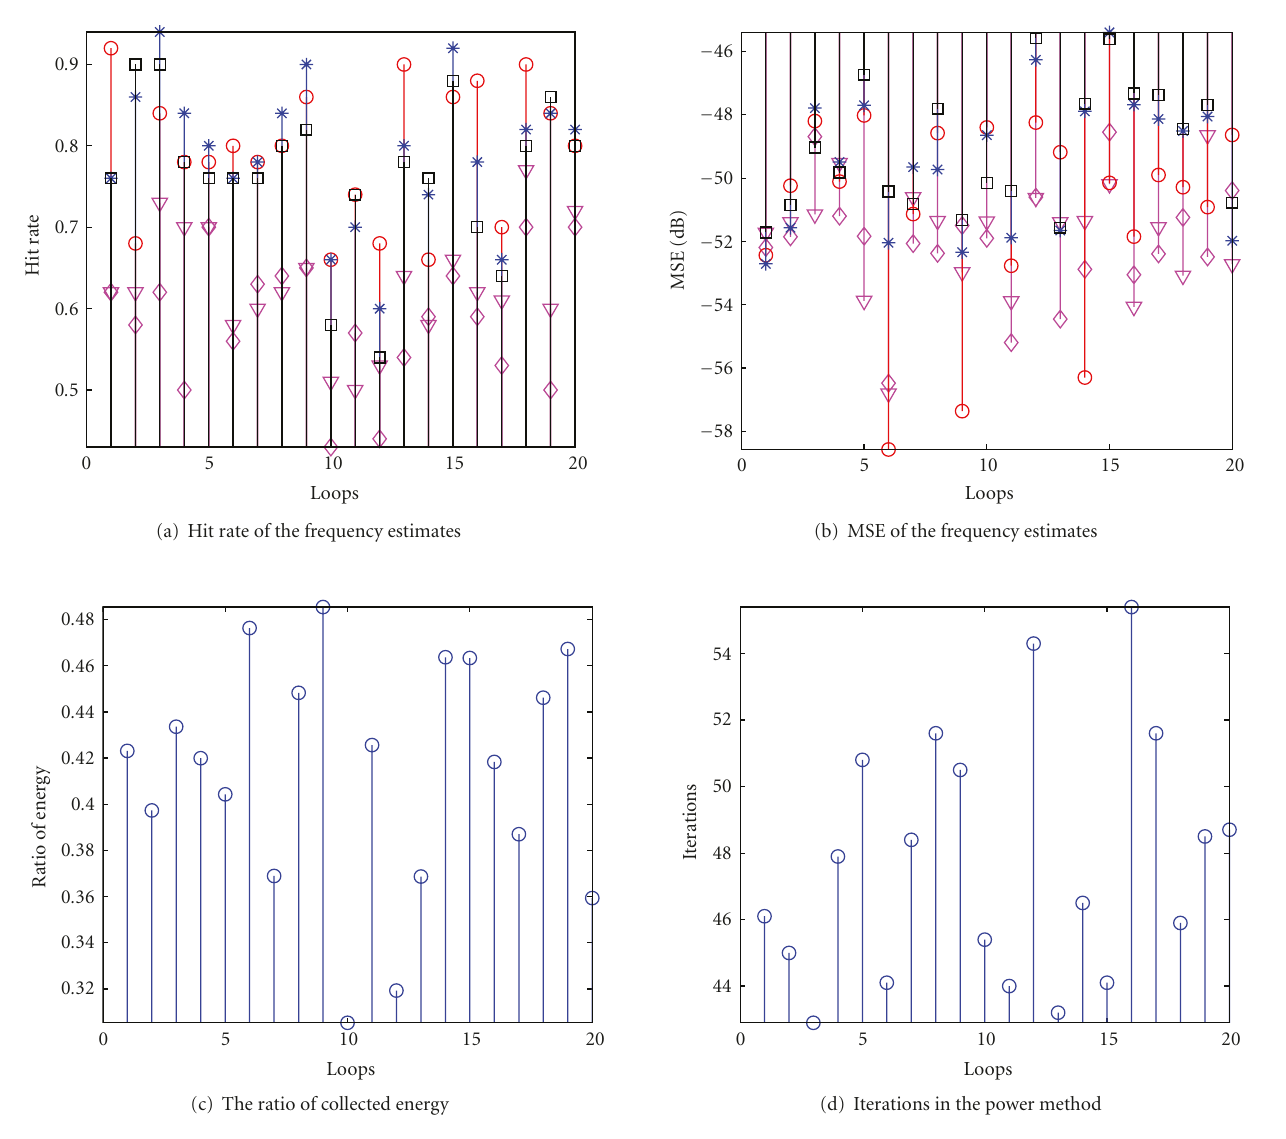
Figure 3: Implementations of A1–A5 with p = 5, L = 50, SNR = 5 dB, and M =